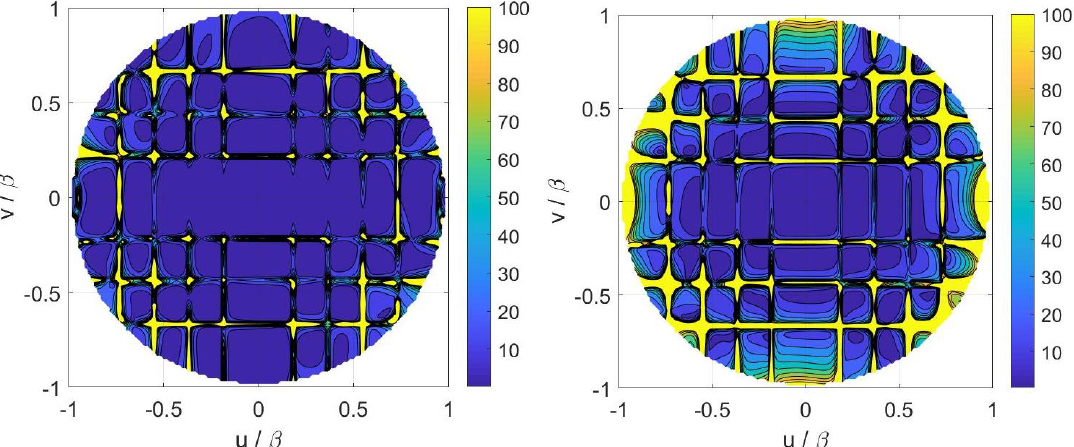
Figure 12. Case B—( Left ) Percentage error of the FFP retrieved in the mutual information case. ( Right ) percentage error of the FFP retrieved in the Fisher information case.